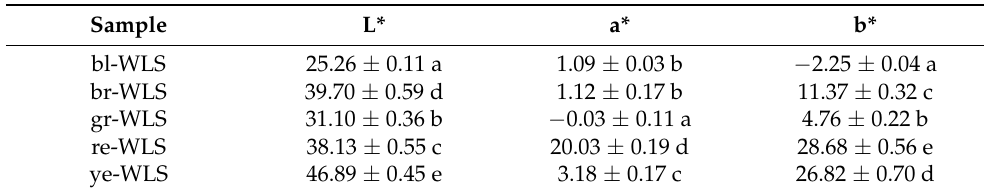
Table 3. Colour parameters of whole grains, brans and flours from different lentil varieties compared to white rice